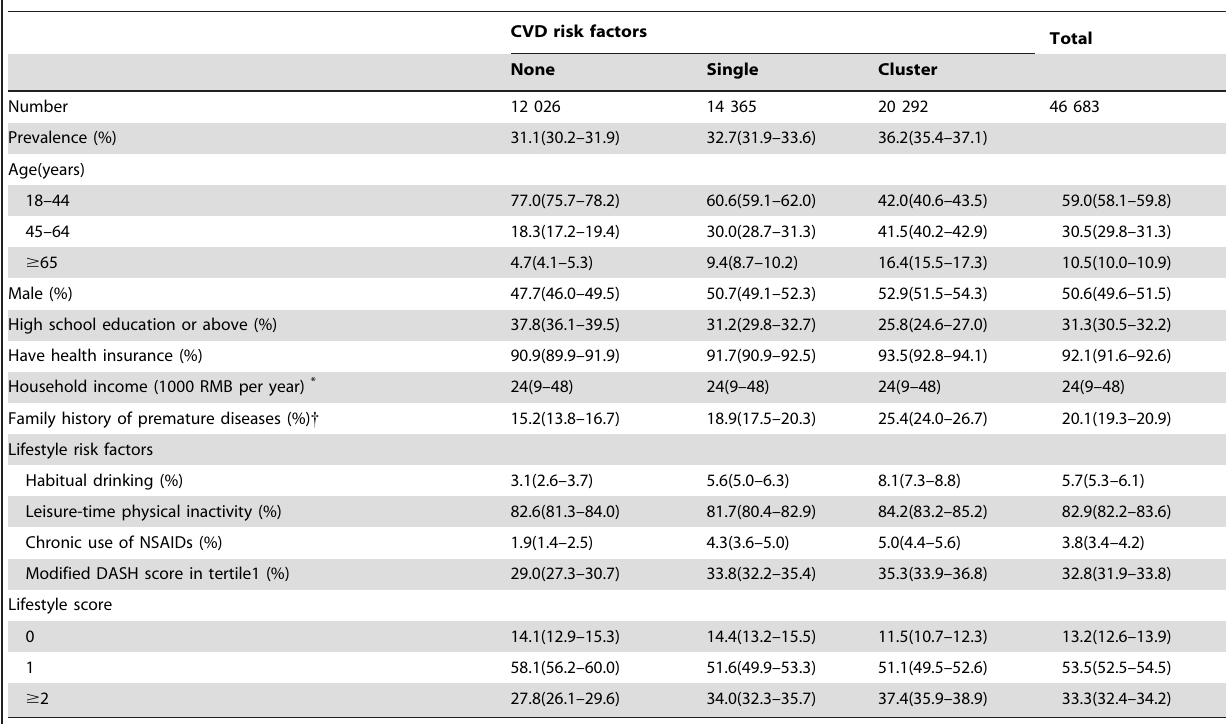
Table 1. Characteristics of participants according to CVD risk factors.*